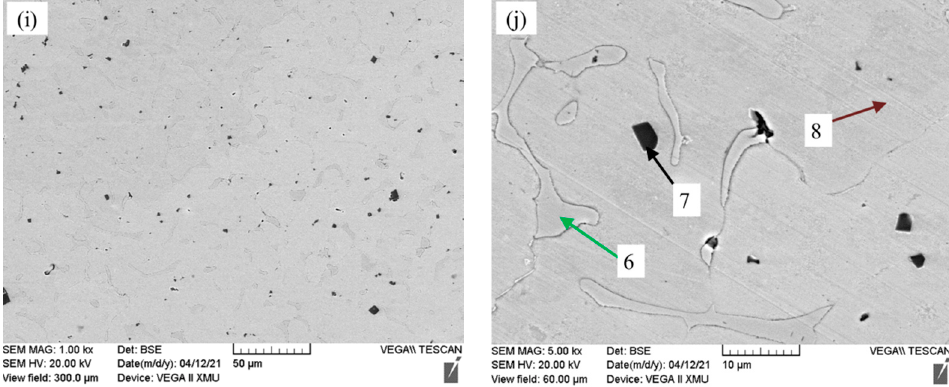
Figure 3. Microstructure of Fe-25Mn-9Al-8Ni-1C-xTi alloy. ( a , b ) 0 wt.% Ti; ( c , d ) 0.1 wt.% Ti; ( e , f ) 0.2 wt.% Ti; ( g , h ) 0.3 wt.% Ti; ( i , j ) 0.4 wt.% Ti. Table 2. EDS analysis of Fe-25Mn-9Al-8Ni-1C-xTi alloy in Figure 3. Element/(at.%) Point